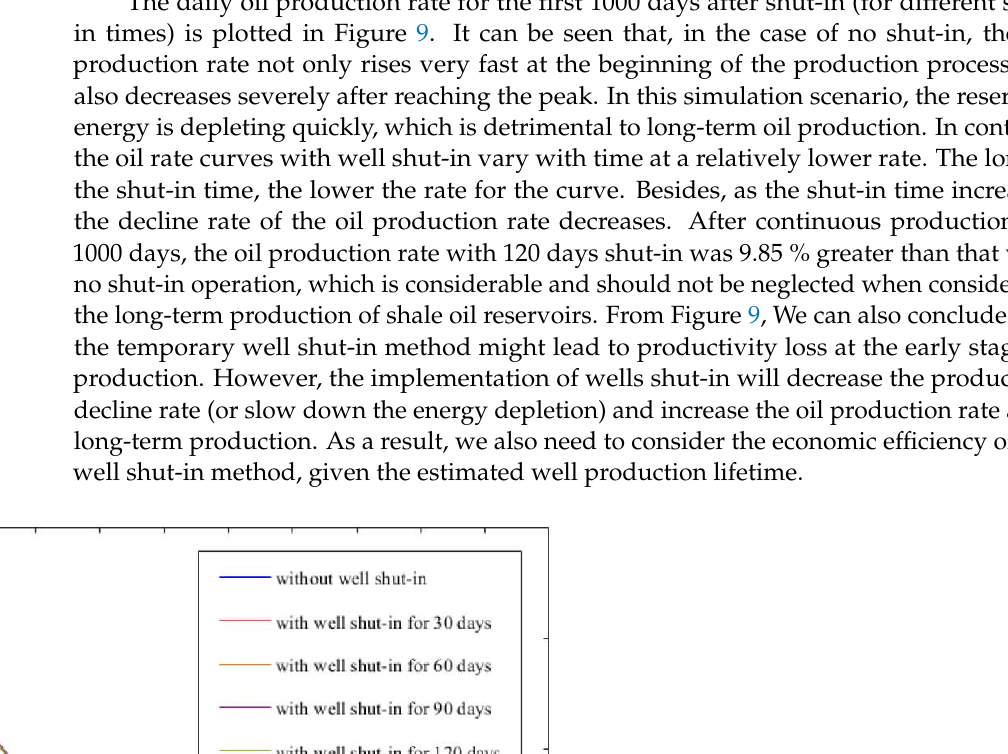
Table 4. Peak production rate and their timings according to five simulation scenarios.